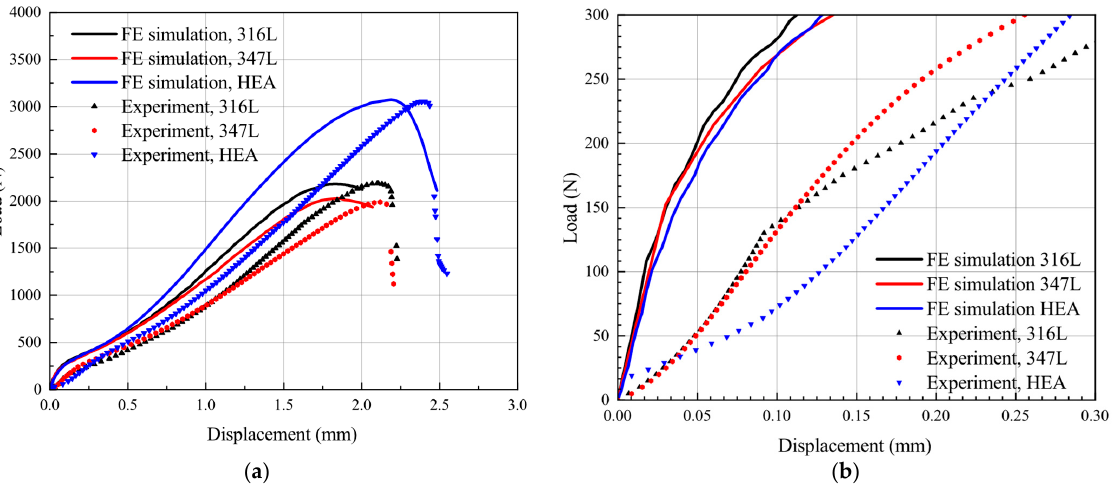
Figure 9. Comparison of force–displacement curve between the experiment and FE simulation. ( a ) at all stages; ( b ) at the initial stage. all stages; ( b ) at the initial